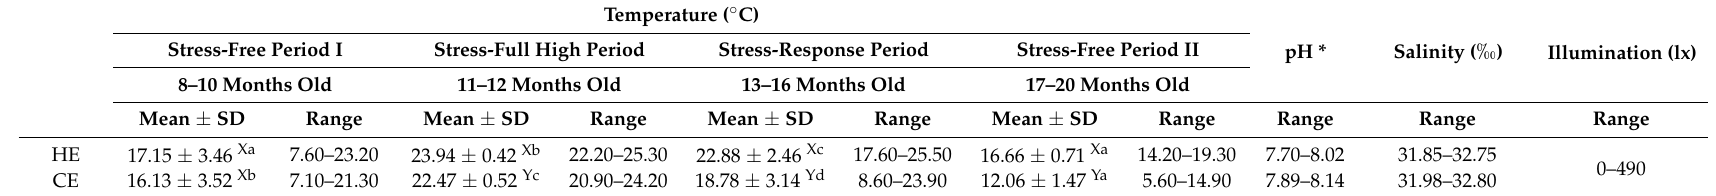
Table 1. Environmental conditions of the two simulated temperature environments.